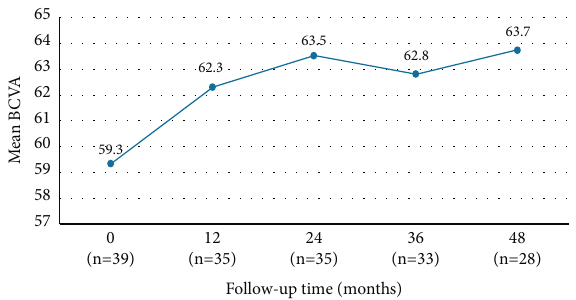
Figure 1: Best-corrected visual acuity (ETDRS letters) variation until 48 months (primary outcome). ∗ P < 0 .